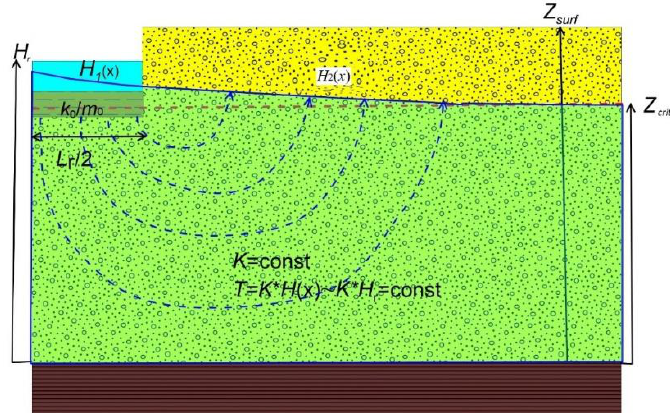
Figure A1. Schematic flow of groundwater discharge in an evapotranspiration ( ET ) zone located along a stream.